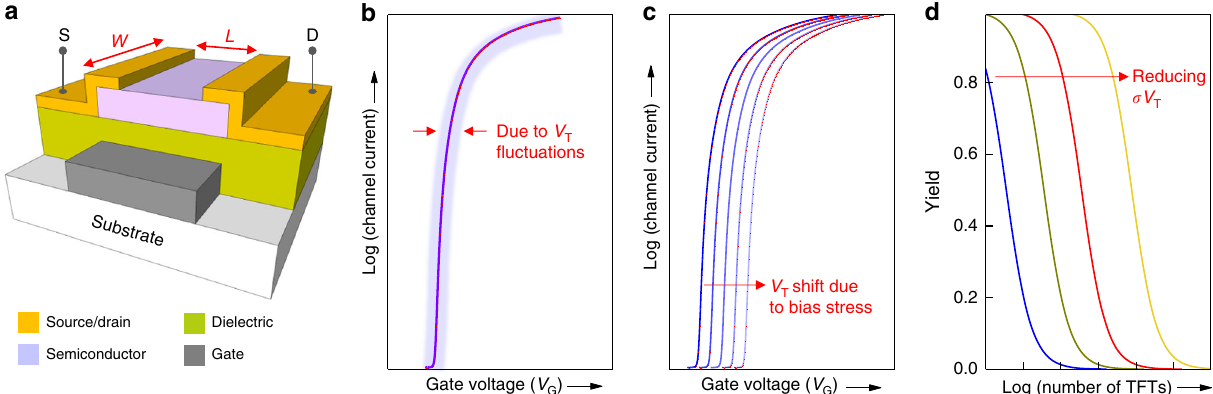
Fig. 1 Thin- fi lm transistor architecture and the important device metrics. a Generic schematic of a staggered bottom-gate TFT. b Conceptual transfer curve (solid line) and characteristic spread (shaded region) attributed to threshold voltage fl uctuations for a large set of TFTs. c Conceptual illustration of the transfer curve shift due to continuous bias application. d Approximate plot of the circuit yield as a function of the number of concatenated unipolar NOT gates using σ V T as the only variable parameter. The plot shows that the less V T fl uctuates (i.e. σ V T becomes smaller), the larger the number of logic gates/ TFTs that can be integrated onto the same